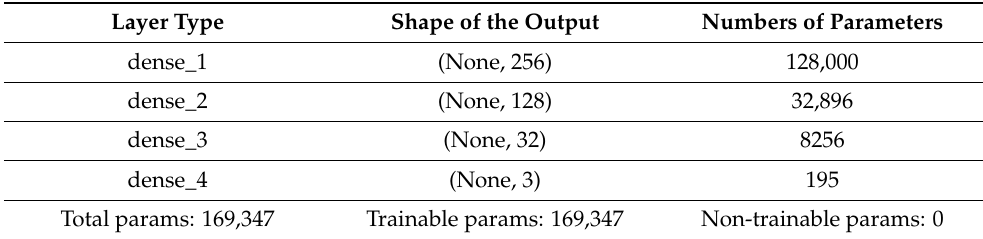
Table 1. Layer-wise parameters of the designed ANN model.